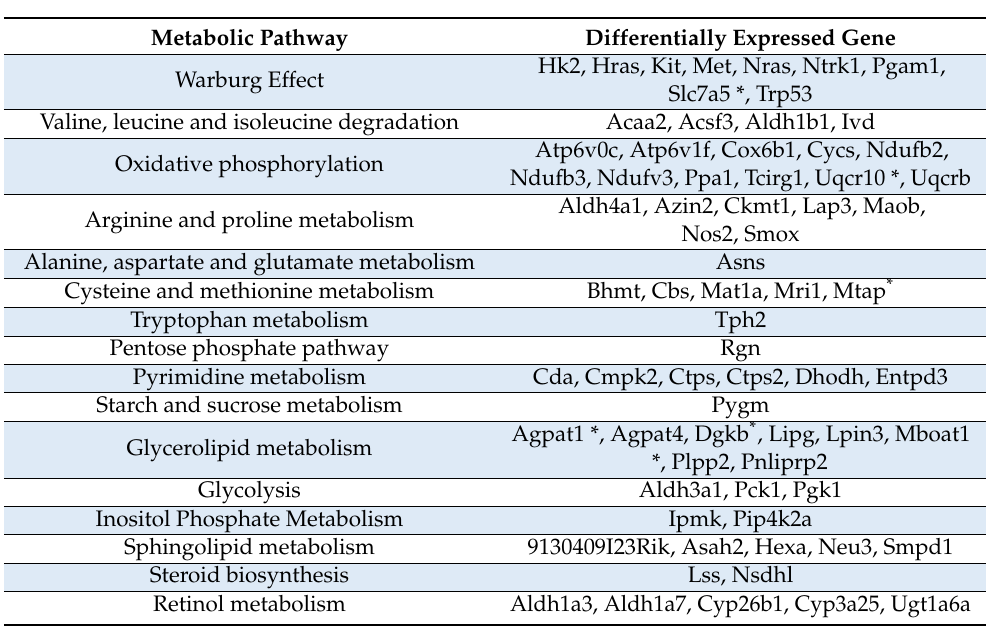
Table 1. Differentially expressed metabolic enzyme-related genes via integrating transcriptome– metabolome